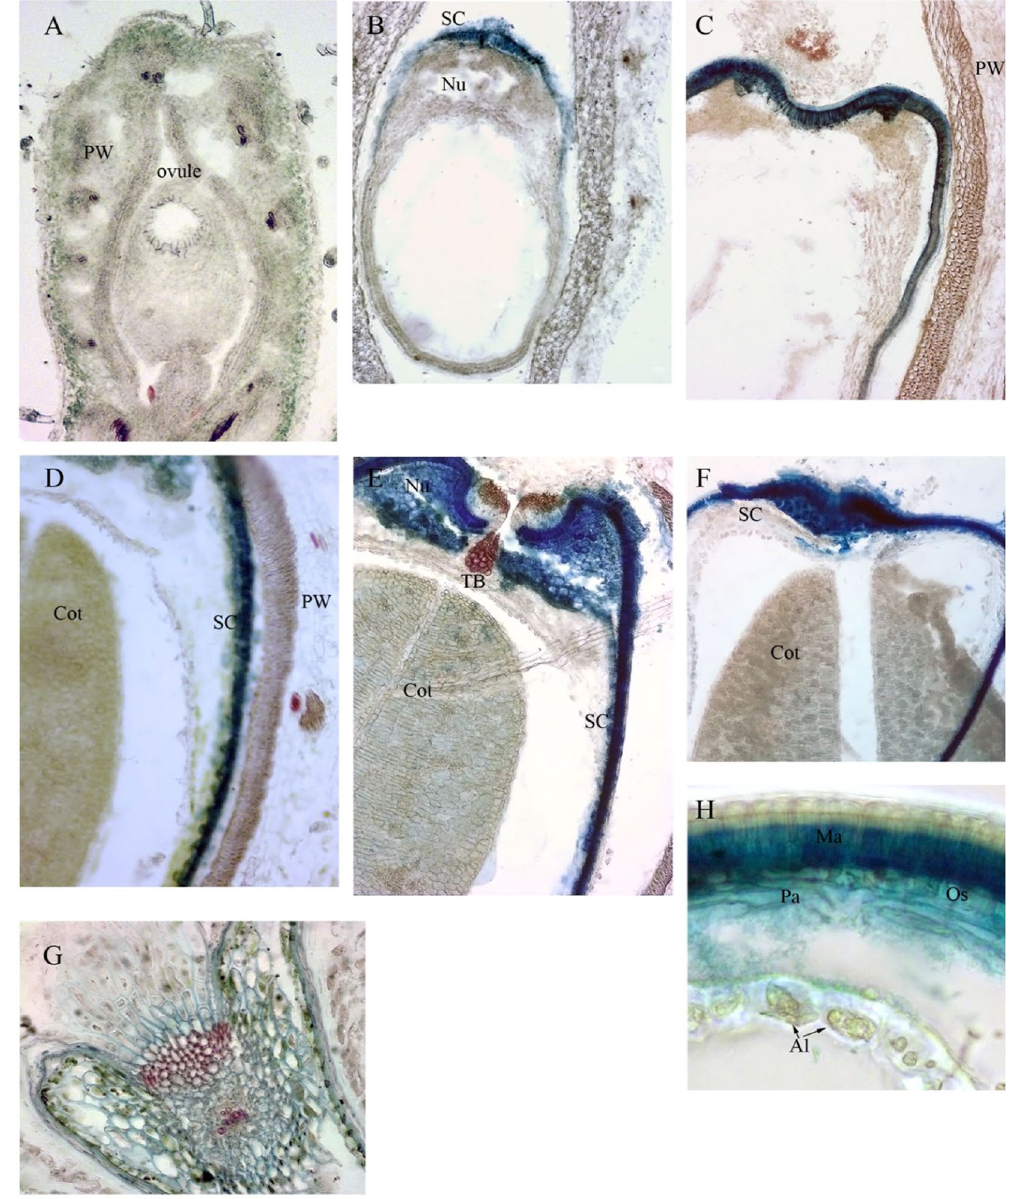
Figure 1. Localization of Phenolic compounds in the pods and seeds of M . truncatula at 3, 6, 13, 20, 27 and 39 DPP. ( A ) Pod at 3 DPP (134X), ( B ) Pod at 6 DPP (134X), ( C ) Pod wall, seed coat & cotyledon at 13 DPP (134X), ( D ) Pod wall, seed coat & cotyledon at 20 DPP (268X), ( E ) Pod wall, seed coat & cotyledon at 27 DPP (268X), ( F ) Pod wall, seed coat & cotyledon at 39 DPP (268X), ( G ) Wheat at 24 DPP as positive control (268X), ( H ) Seed coat at 39 DPP (538X). Al, Aleurone cell; Cot, Cotyledon; Ma, Macrosclereids; Nu, Nucellus; Ovule; Pa, Parenchyma; PW, Pod wall; SC, Seed coat; TB, Trachid